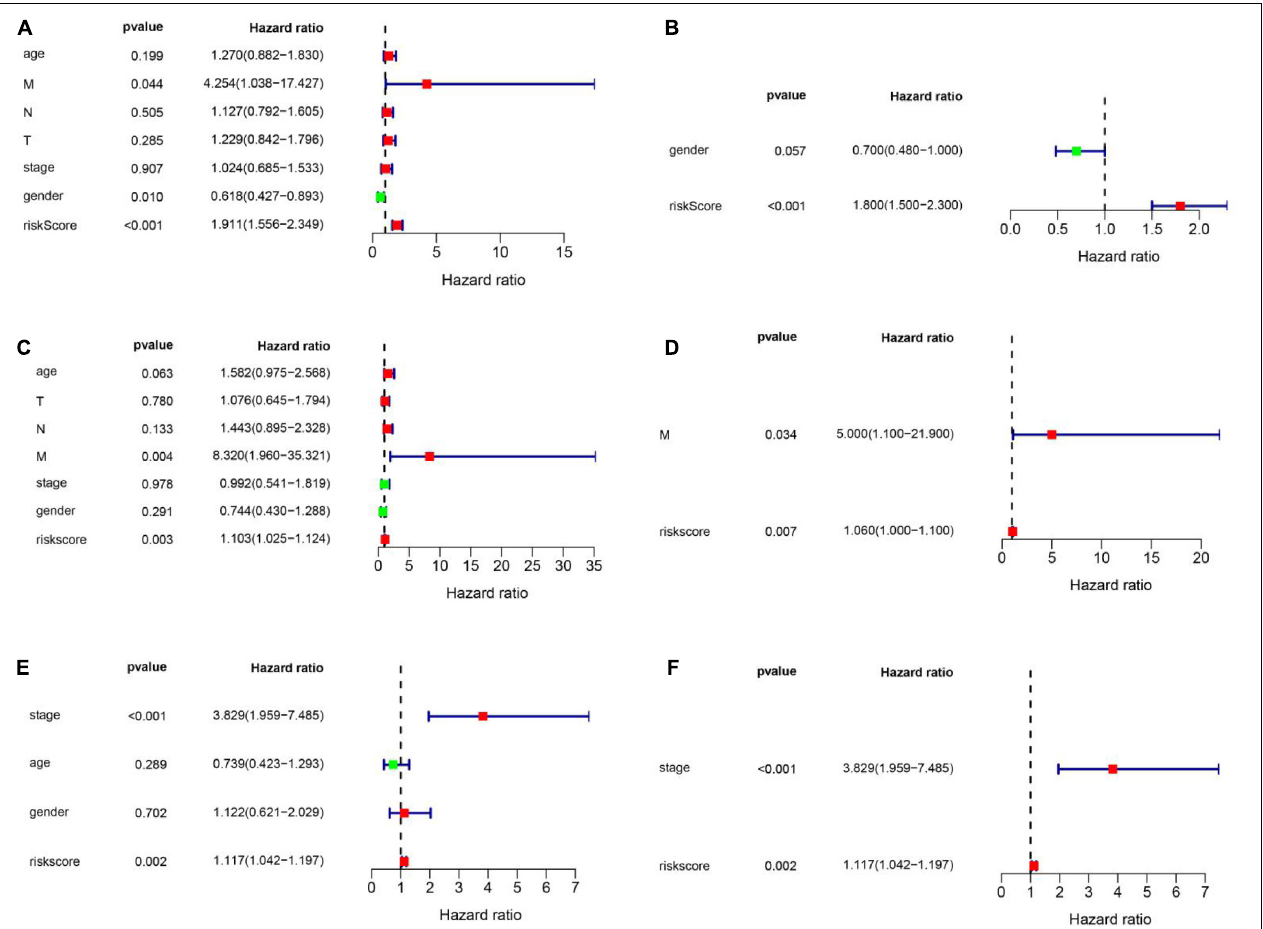
FIGURE 6 | Univariate and multivariate Cox analyses were employed to assess the ability of the risk score and other clinical factors to predict overall survival. The forest plots show the hazard ratio and 95% confidence interval values. (A,B) Results of the univariate and multivariate Cox regression analyses regarding OS in the TCGA training set. (C,D) Results of the univariate and multivariate Cox regression analyses regarding OS in the TCGA validation set. (E,F) Results of the univariate and multivariate Cox regression analyses of OS in the GEO validation